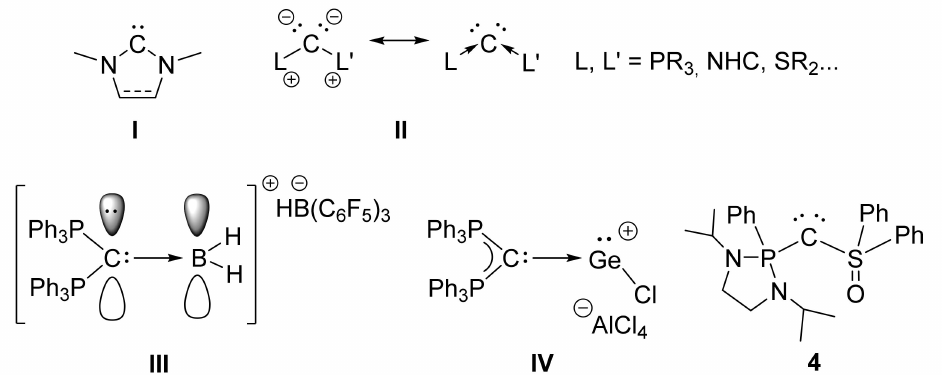
Figure 1. NHC ( I ), carbones ( II) , dihydrido borenium ( III ) and germyliumylidene ( IV ) stabilized by carbodiphosphoranes and phosphine/sulfoxide-supported carbone 4 (for a better readability, formal charges in ( III , IV ) and 4 were